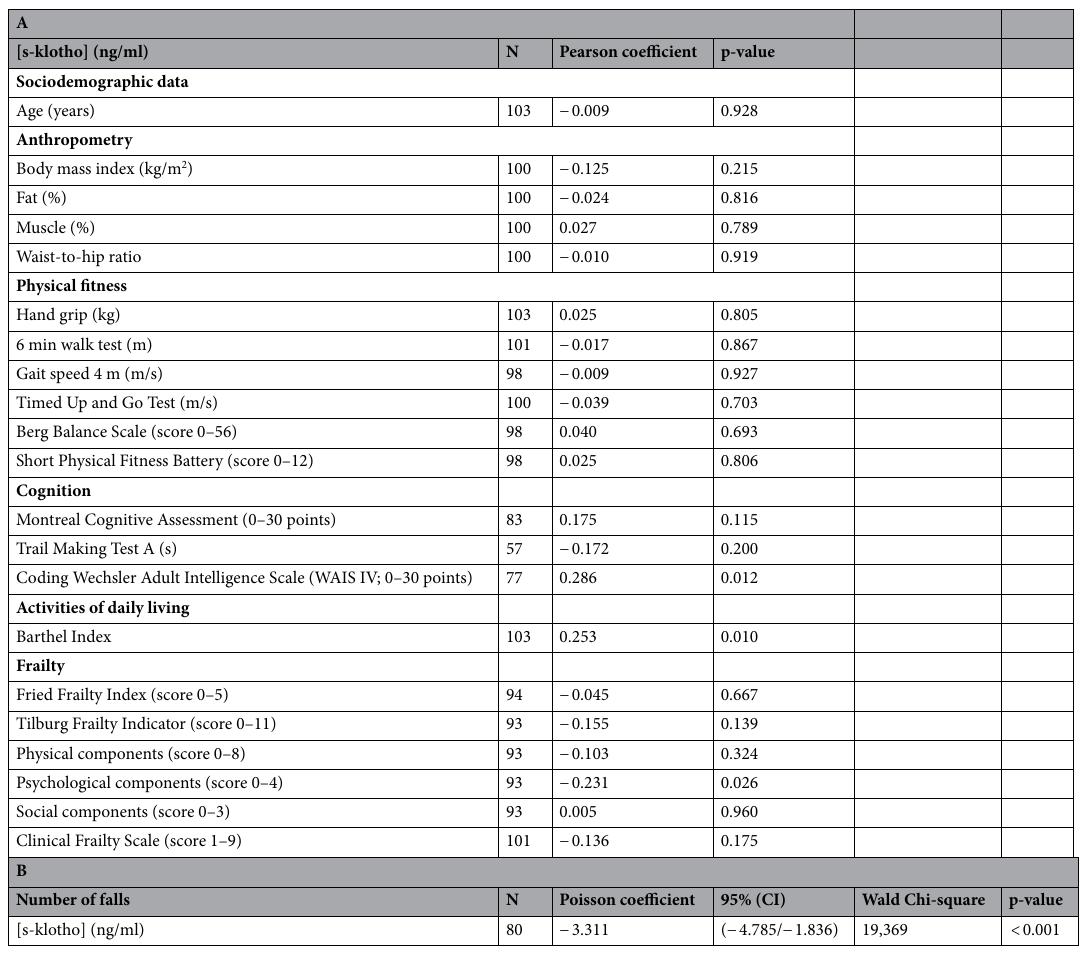
Table 2. Correlations between s-klotho concentration and quantitative variables. A: Pearson correlations for sociodemographic data, anthropometry, physical fitness, cognition, activities of daily living and frailty scores. B: Poisson correlation for number of falls. CI Confidence